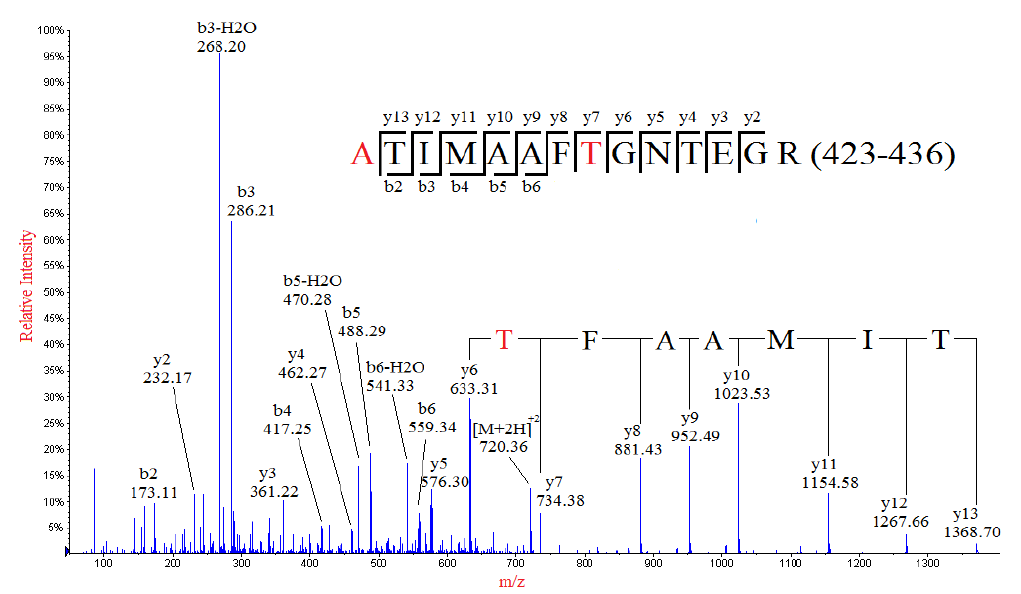
-H O, b , 3 2 3 → A and N → T. 423 430